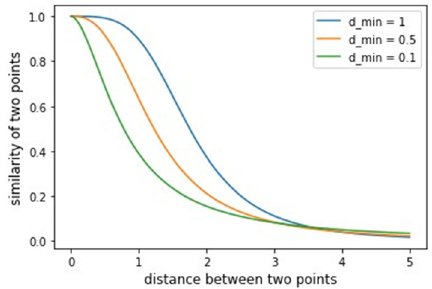
parameter value. (cid:3040)(cid:3036)(cid:3041)